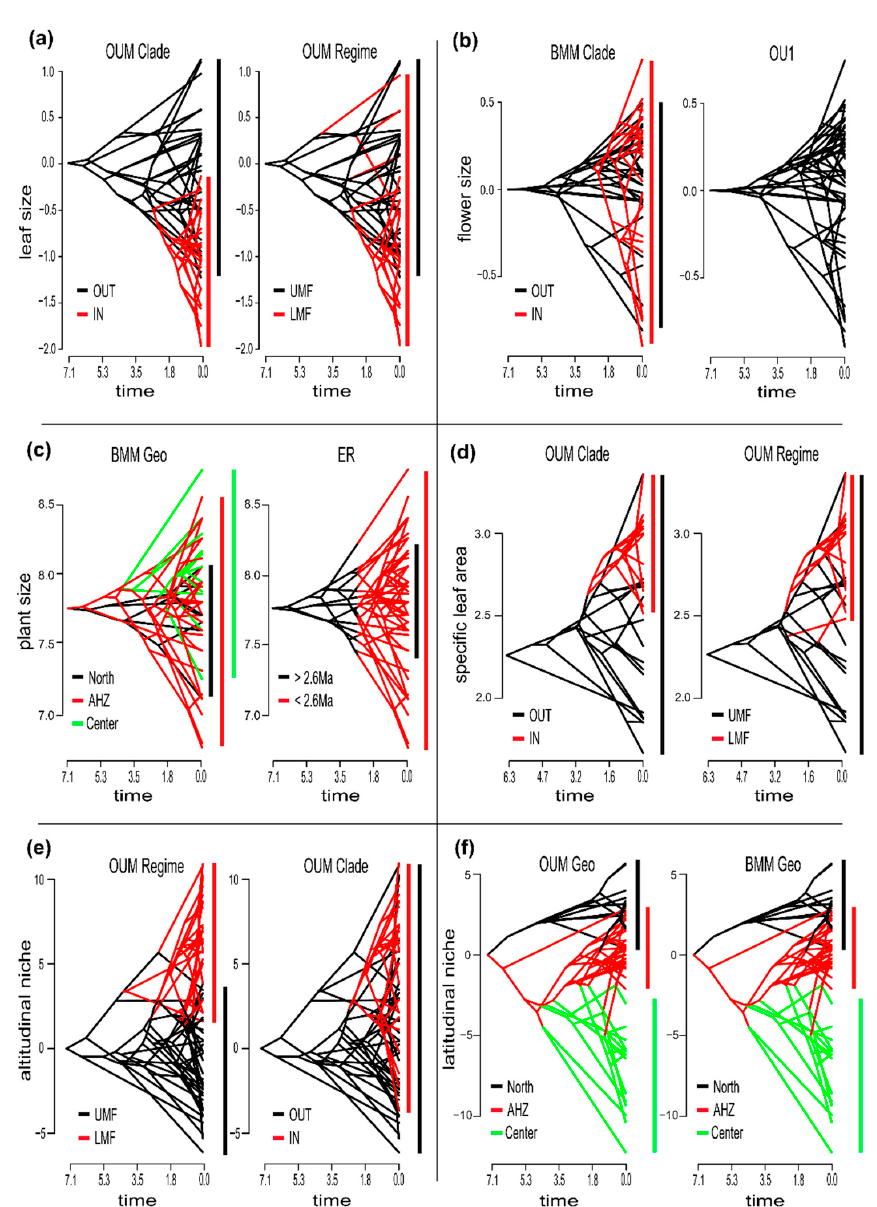
Figure 5. Phenograms reconstructed by using the R package phytools (Revell, 2012) for the 6 traits investigated in the study. The x-axes represent the time in Myr and the y-axes the trait values. The method uses a maximum likelihood approach to infer the ancestral value at internal nodes. For each trait, two phenograms are displayed with branch colors representing alternative mappings that were used to fit the two best ‐ fitting models (see Table 3 for models scores). Vertical lines on the right of the phenograms represent the trait range value for each mapped state. ( a ) For leaf size the best fitting model is the OUM Clade (see caption of the Figure 4 and Methods for details concerning the models) followed by the OU1, but here we decided to represent the OUM Regime instead (3 rd best model), for discussion purpose. IN and OUT mean inside and outside the M. micrantha clade respectively. UMF and LMF refer to the upper (>1800 m) and lower (<1800 m) montane forest respectively. ( b ) For flower size the two best models are the BMM Clade and OU1. ( c ) For plant size, the BMM Geo and the ER are the two best models. North, AHZ, and center refer to the Northern Andes, the Amotape ‐ Huancabamba zone and the Central Andes respectively whereas >2.6 Ma and <2.6 Ma refer to the part of the trees older and contemporaneous with the Pleistocene climatic oscillations respectively. ( d ) For specific leaf area the OUM Regime and OUM Clade obtain almost equivalent fit. ( e ) For the altitudinal niche the OUM Regime obtained the best fit and is followed by the OUM Clade. ( f ) For the latitudinal niche, the best ‐ fitting model is the OUM Geo, followed by the BMM Geo.